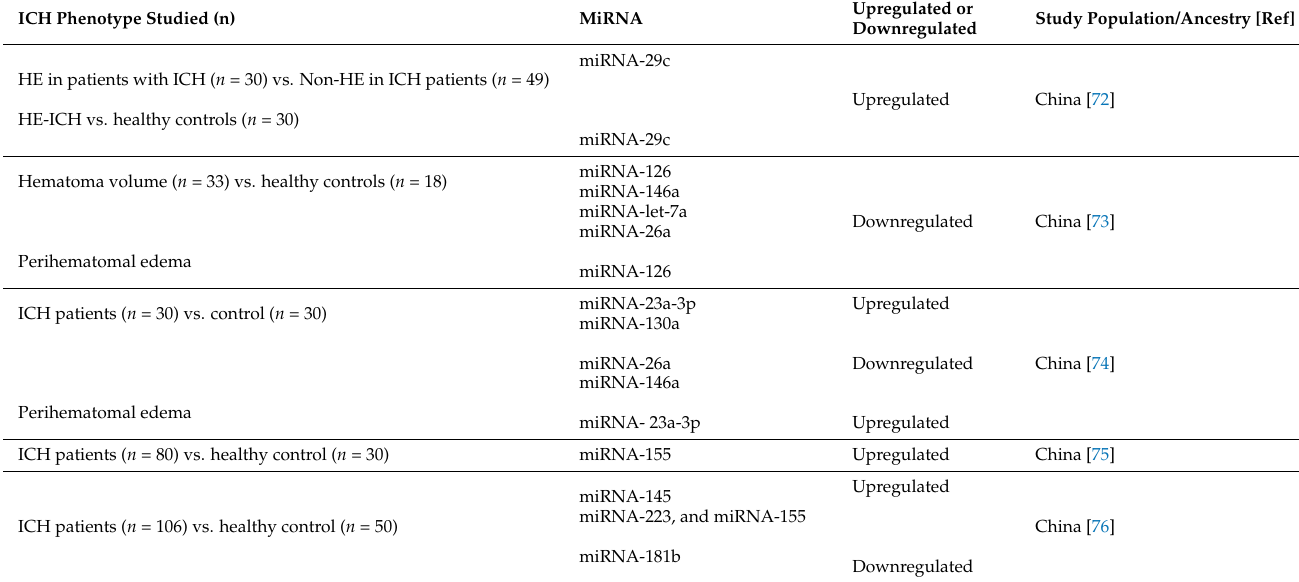
Table 1. Summary of microRNAs differentially expressed in patients with primary intracerebral hemorrhage respect to healthy controls, in more than two independent studies. Papers that lacked quantitative analysis were excluded. Based on the systematic review performed by Fullerton and co-workers